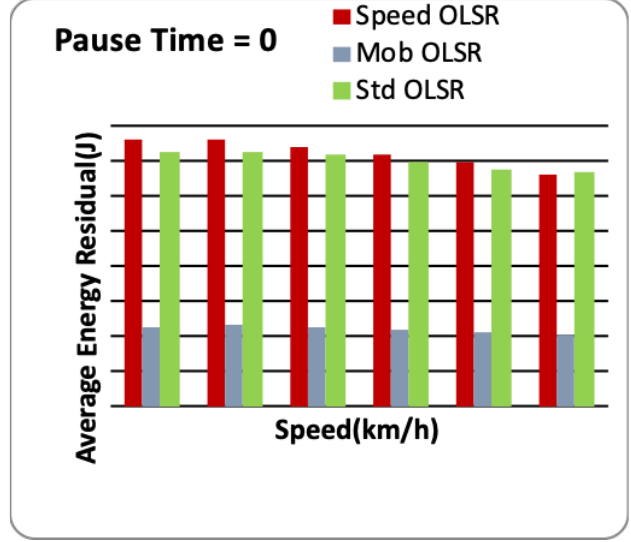
Fig. 9. Average Energy Residual(J) depending on the nodes speed